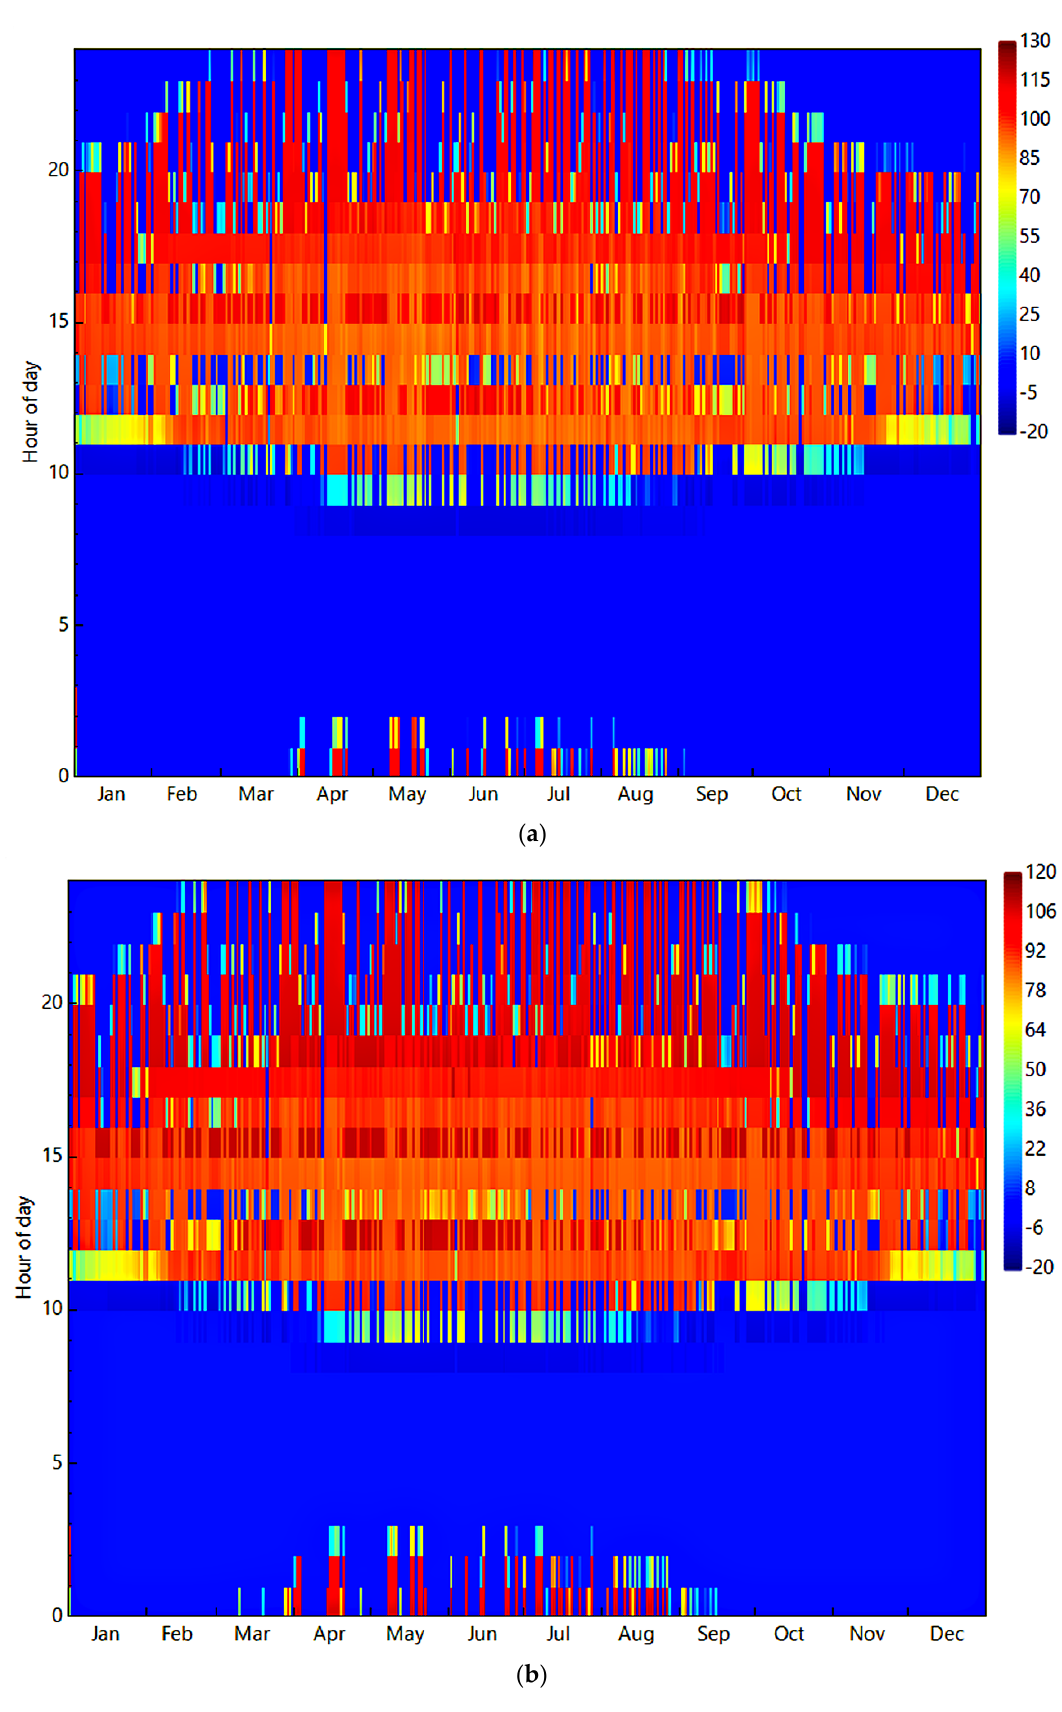
Figure 6. Electricity to grid (MWe) for ( a ) Rankine ( b ) sCO 2 power